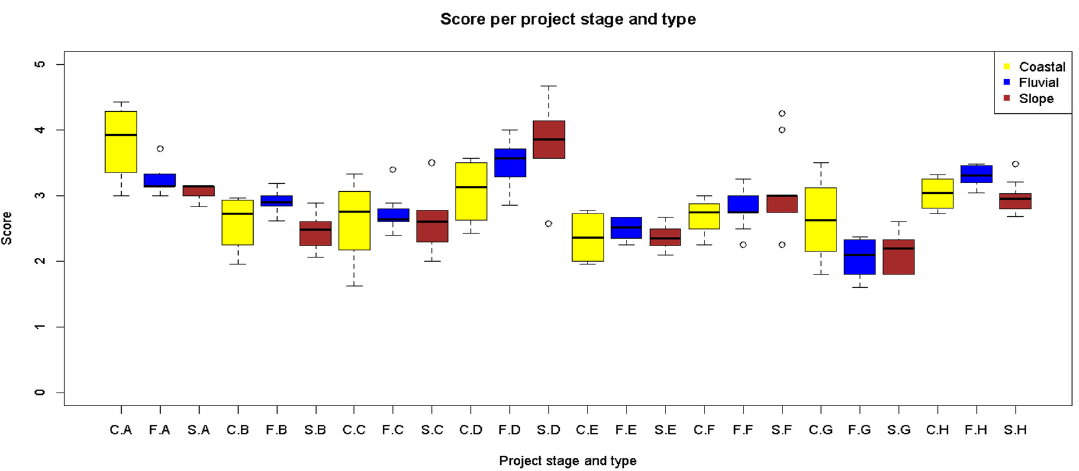
Figure 9. Differences between the average sustainability performance per project stage and type. C: coastal; F: fluvial; S: slope. The project stages are shown in Figure 8 ′ s legend. The lower edge of the box corresponds to the 25th percentile data point, while the top edge of the box corresponds to the 75th percentile data point. The line within the box represents the median. The highest and lowest scores excluding outliers are shown in the upper and lower whiskers. The outliers detected denote higher score variability in fluvial and slope projects than in coastal projects.